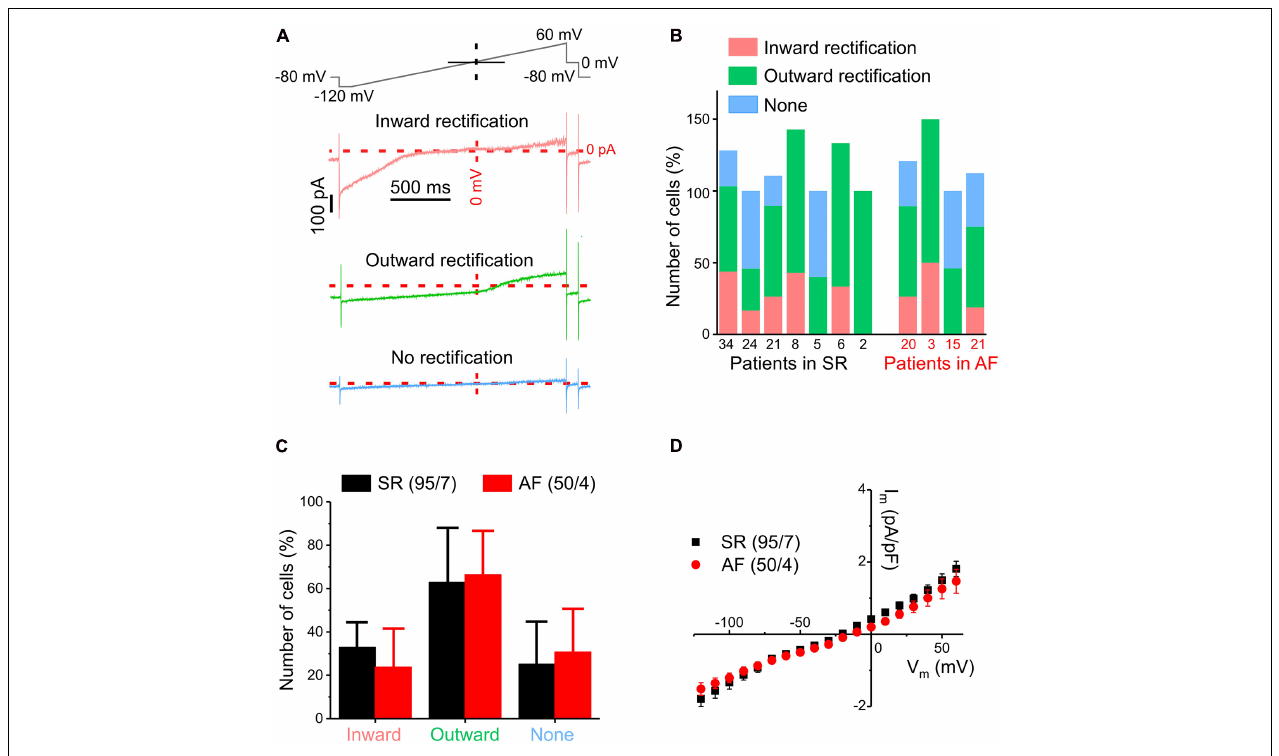
FIGURE 1 | Overview of different ion current patterns in human atrial fibroblasts recorded using a ramp pulse protocol in whole-cell mode. (A) Exemplary traces of different current types (inward rectification, outward rectification, no rectification) with the ramp protocol used (top trace). (B) Distribution of current types between cells from different patients with SR or AF. Note that percentages may add up to > 100% because some cells show both inward and outward rectification; the number of cells assessed for each patient is indicated below the x-axis. (C) Distribution of current types between cells from SR and AF patients (error bar =